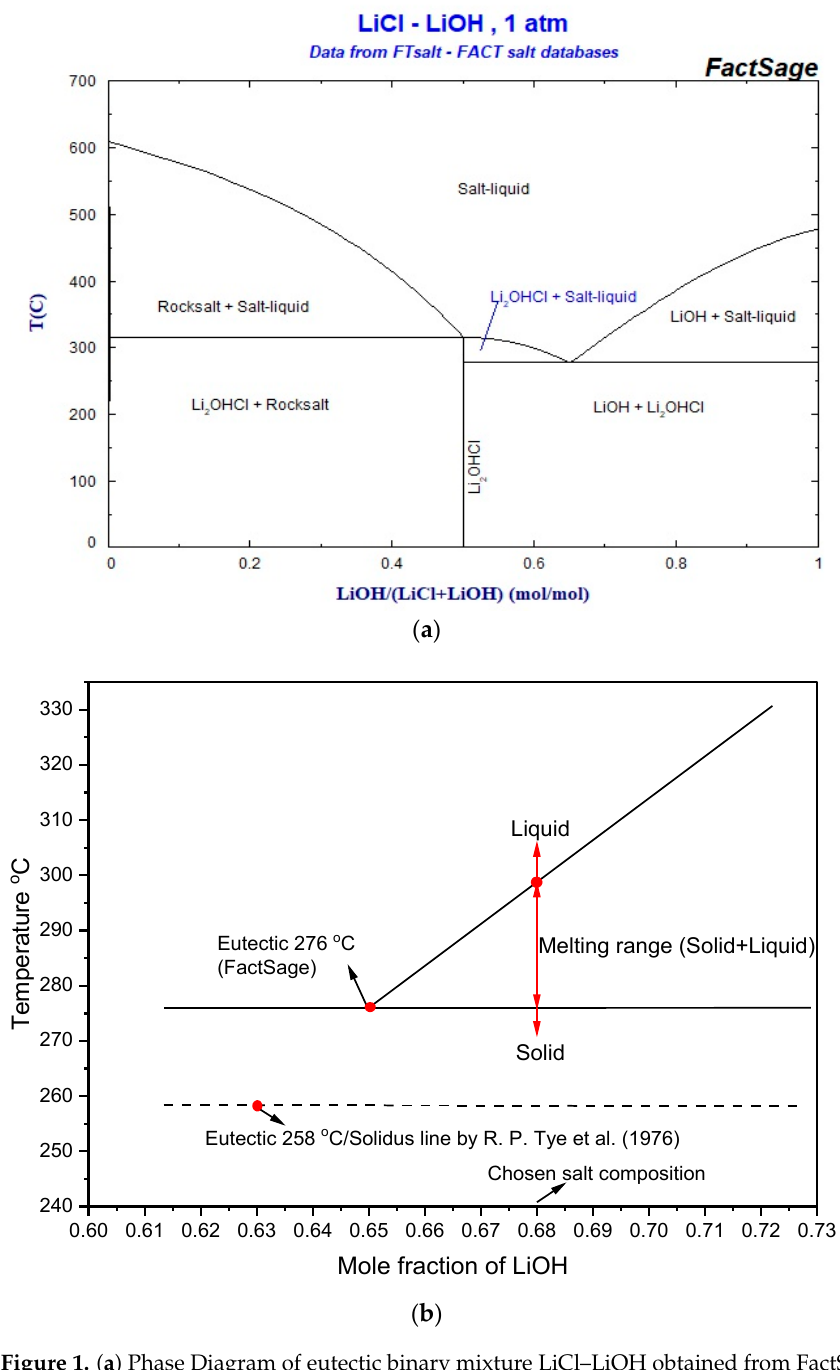
Figure 1. ( a ) Phase Diagram of eutectic binary mixture LiCl–LiOH obtained from FactSage (FactSage, 28 March 2022). ( b ) Phase diagram of investigated binary salt mixture 32 mol% LiCl-68 mol% LiOH derived from FactSage tool and Ref. [25].